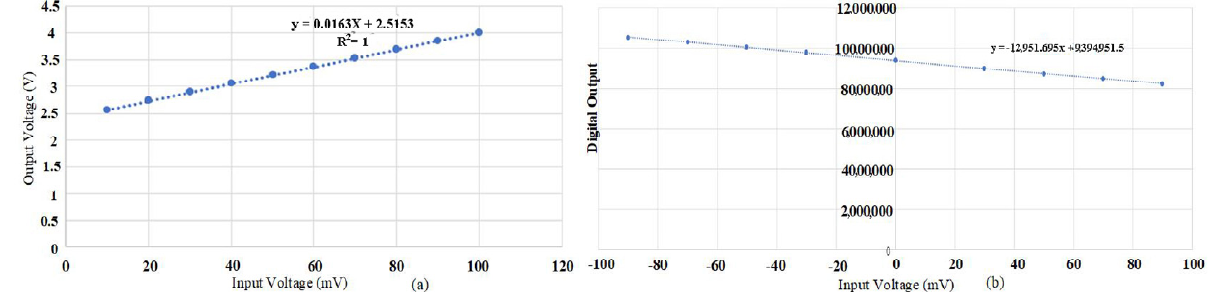
Figure 23. MEMS gyroscope test circuit input and output test results: ( a ) The analog input and output result; ( b ) The digital input and output result.